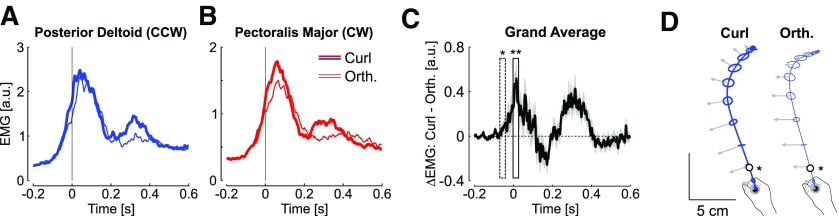

A, Average activity of posterior deltoid in curl (thick) and orthogonal (thin) counterclockwise perturbations across the last 15 trials of each type of force field. B, Same as a for pectoralis major from clockwise perturbations. C, Difference between activities recorded during curl and orthogonal force fields averaged across participants and muscles. The onset of significant changes based on a 30-ms-wide sliding window is highlighted with one star (p < 0.05), followed by strongly significant differences (two stars, p < 0.005). D, Average hand paths during counterclockwise perturbations. Ellipses are two-dimensional standard dispersion across participants every 50 ms, and the impact of the force field is illustrated with the gray arrow (a common scaling for the two force fields was applied for illustration). The open dots are the moment when the activities started to differ across two types of perturbations.